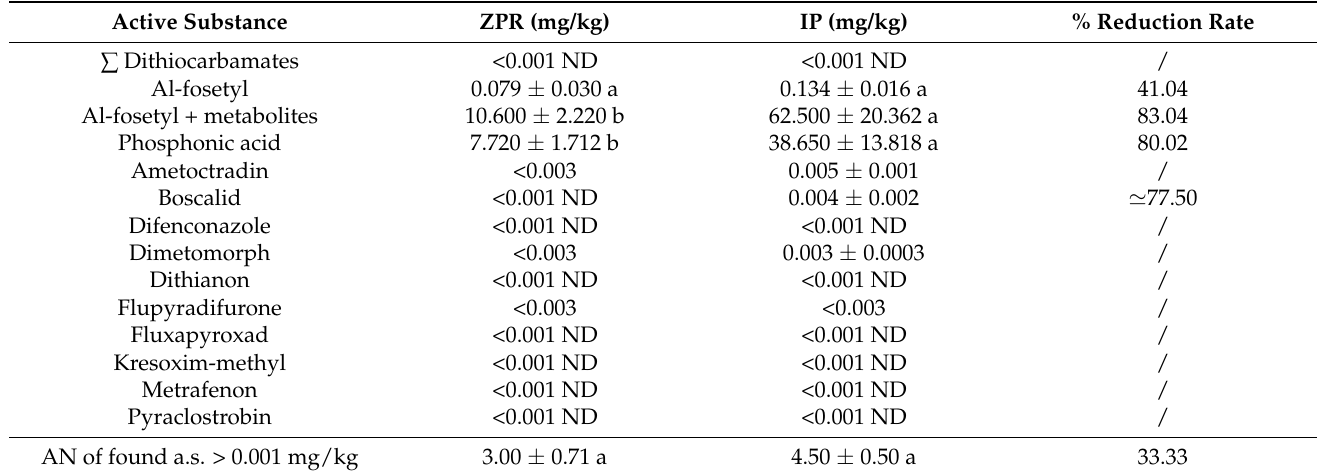
Average concentration (mean ± SE) of pesticide residues in Pinot Gris wine. Result < 0.001 ND means a.s. was not detected at a level higher than 0.001 mg kg − 1 . /—concentration reduction rate and significance of difference between IP (integrated) and ZPR (0-pesticide residue) means cannot be calculated. Pesticide concentration reduction rate (%) = 100 − ((ZPR/IP) × 100) (see explanation in Section